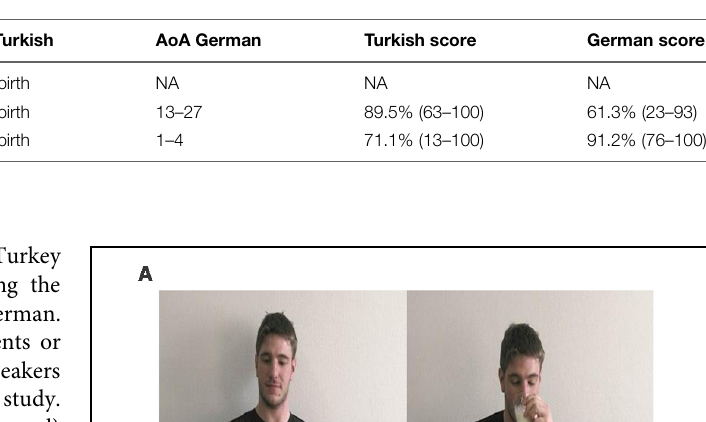
TABLE 1 | Numbers and age of participants, AoA = age of acquisition in years with min-max age range, and proficiency test scores (ranges in brackets) in Turkish and German for bilingual